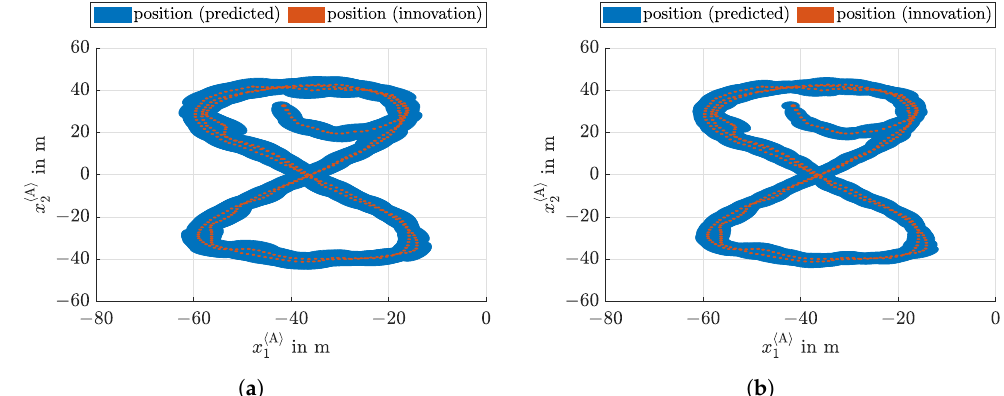
Figure 8. Localization of the DDboat A with heading and velocity measurement. ( a ) Evaluation of the system matrix in (55) for estimated heading information. ( b ) Evaluation of the system matrix in (55) for measured heading information.